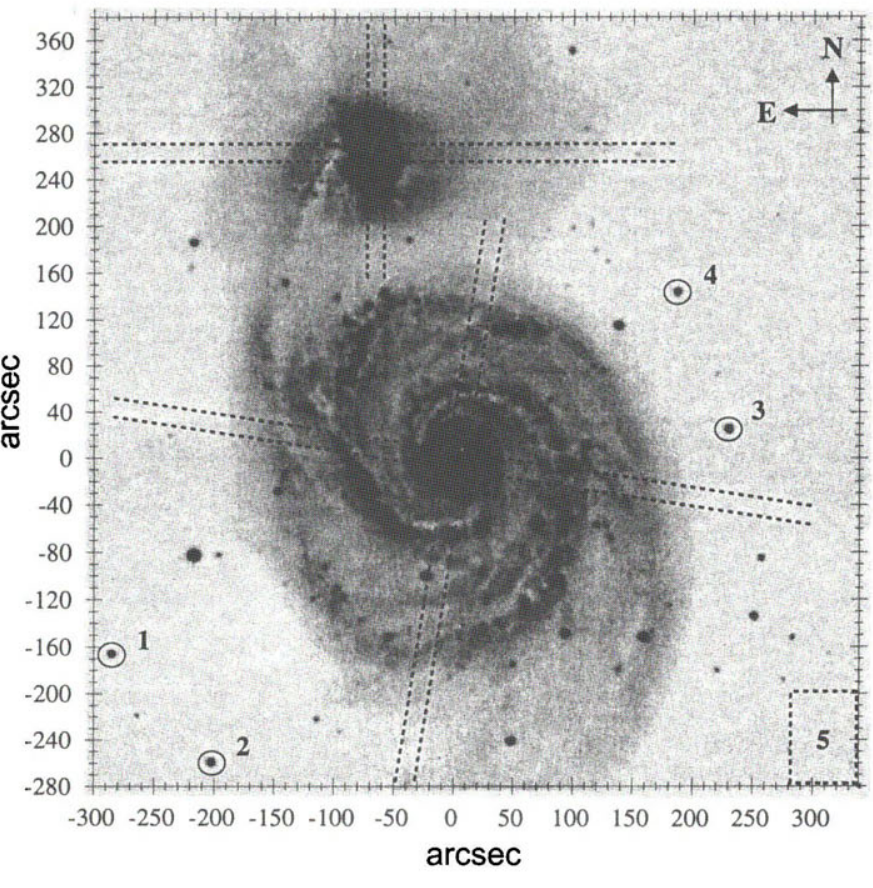
Fig. 1. The galaxies NGC 5194/95 in the B passband, the image size is 10'Xll', the scale is 0.75"/pixel. The directions of the major and minor axes, reference stars (1-4) used for the coordinate transformation and an area (5) used for sky background determination are